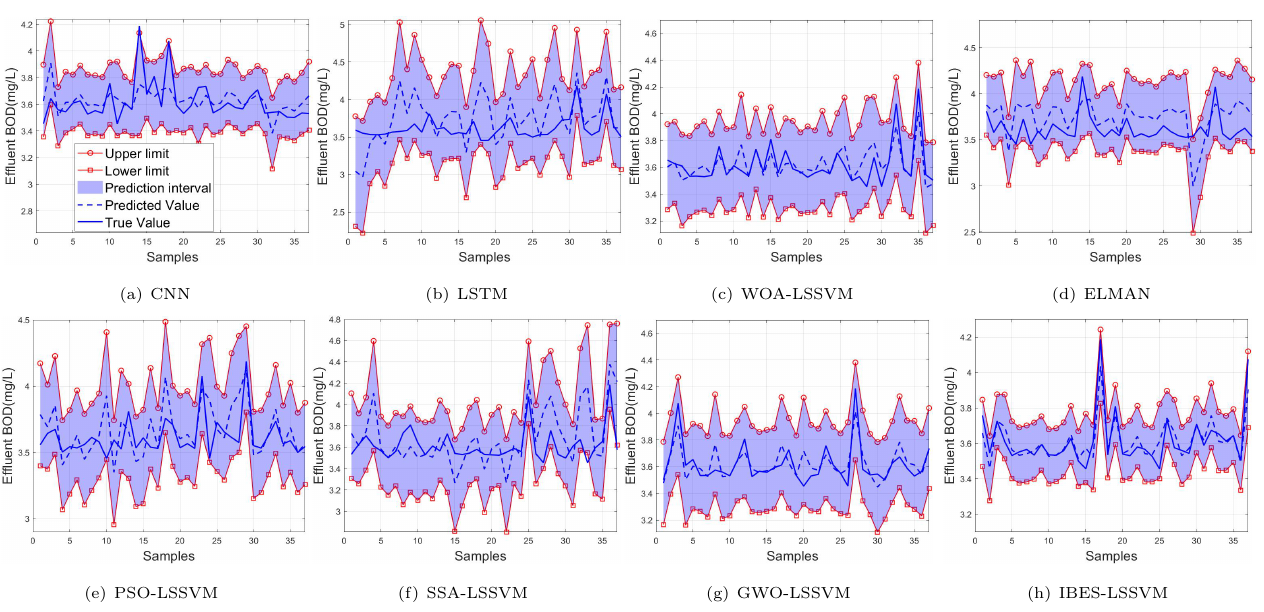
Figure 16. 99% of